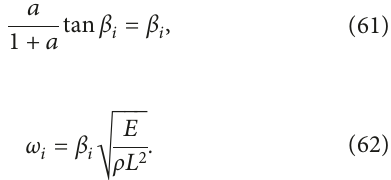
Figure 17: A nonuniform